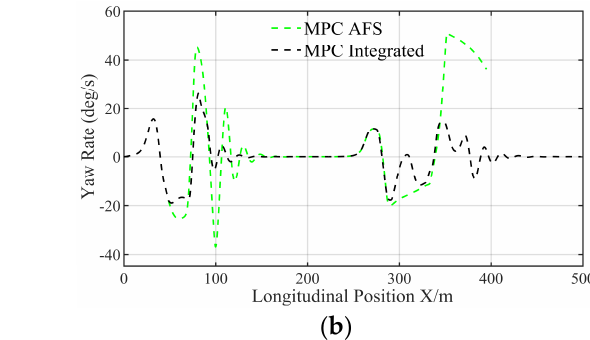
Figure 10. Comparison of ( a ) longitudinal velocity and ( b ) yaw rate at lower speed ( V x = 80km/h).